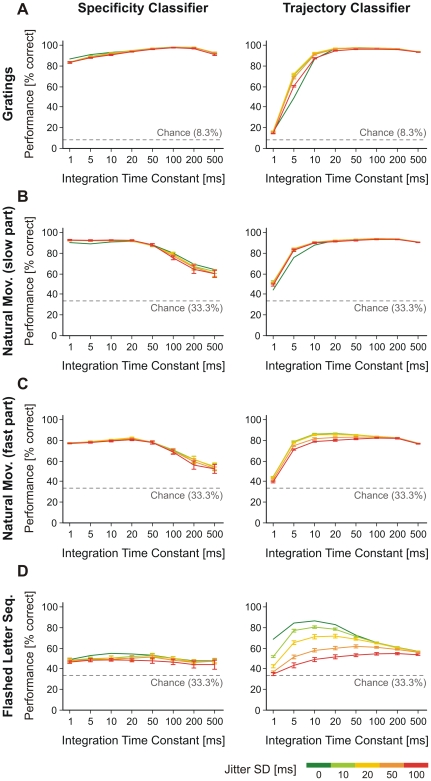
Effect of spike jitter on classification performance.Specificity classifiers (left) and trajectory classifiers (right) for: grating stimuli (A), slow (B) and fast (C) segments of natural movies, and flashed letter sequences (D). The applied jitters are 10 ms (light green), 20 ms (yellow), 50 ms (orange), and 100 ms (red). Original classification performance, without jittering, is shown in dark green curves. Error bars represent s.d. over independent jitters.